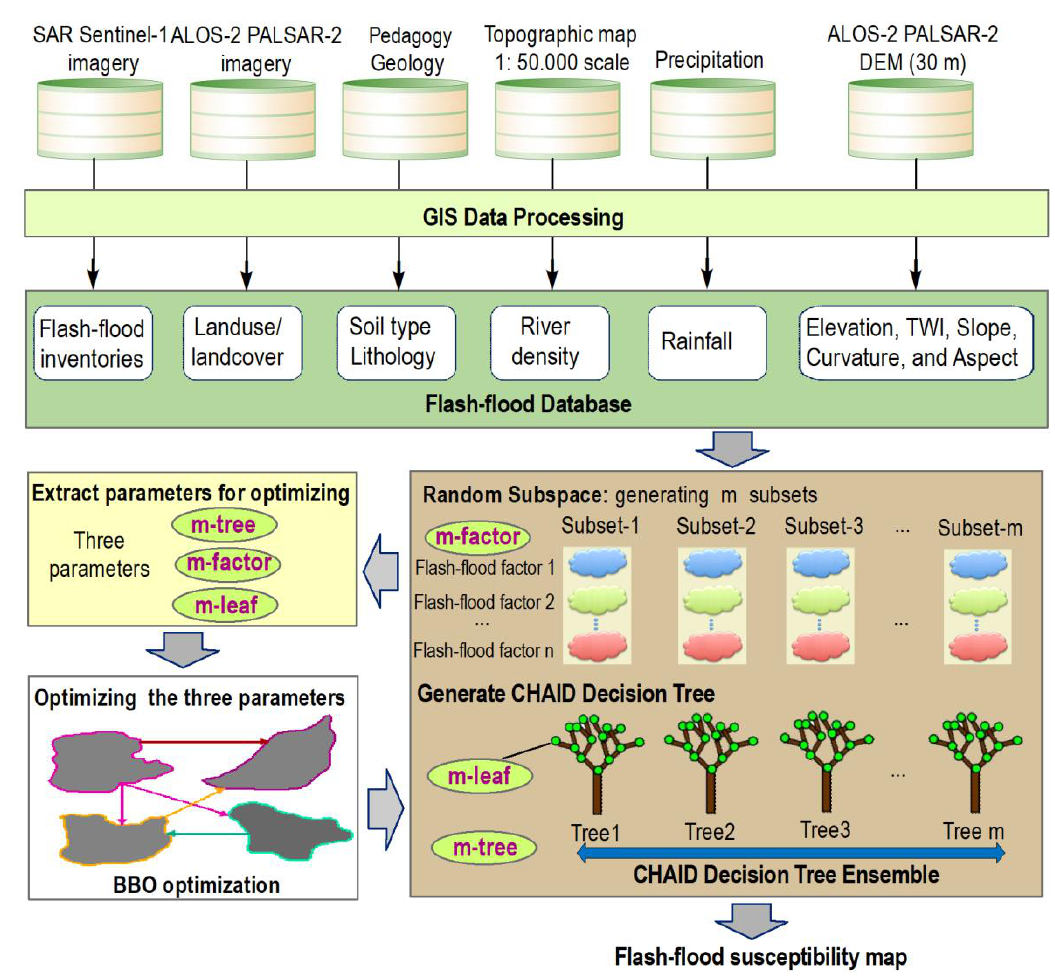
Figure 4. The flowchart with the CHAID-RS-BBO model for predicting flash flood susceptibility.